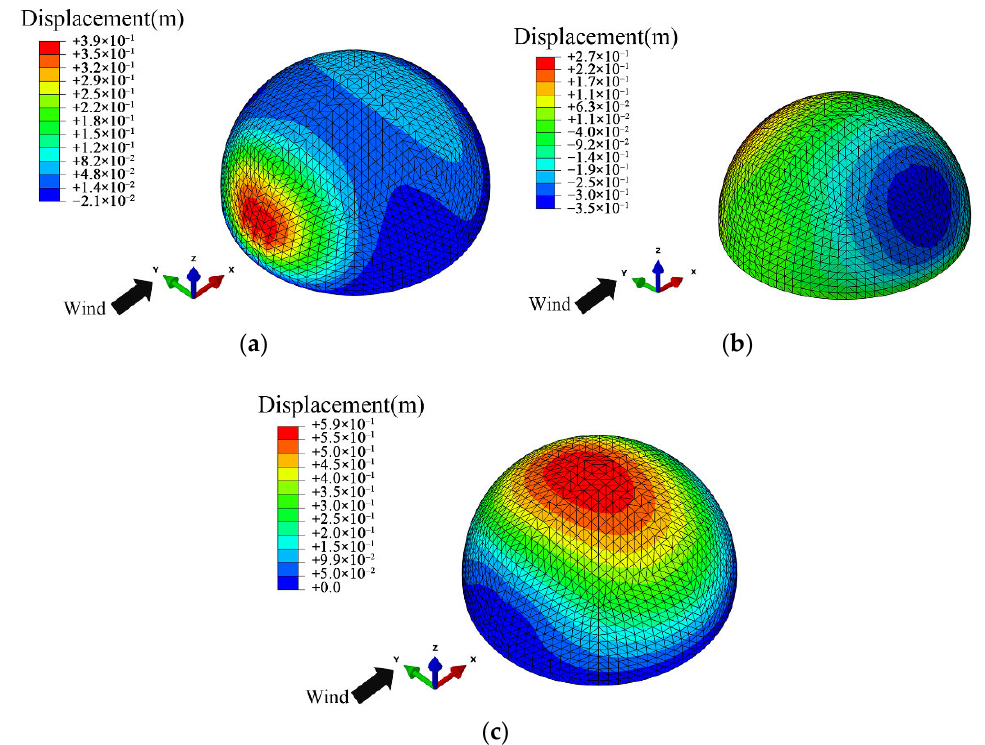
Figure 11. Contours of the maximum displacement component: ( a ) u component; ( b ) v component; ( c ) w component.